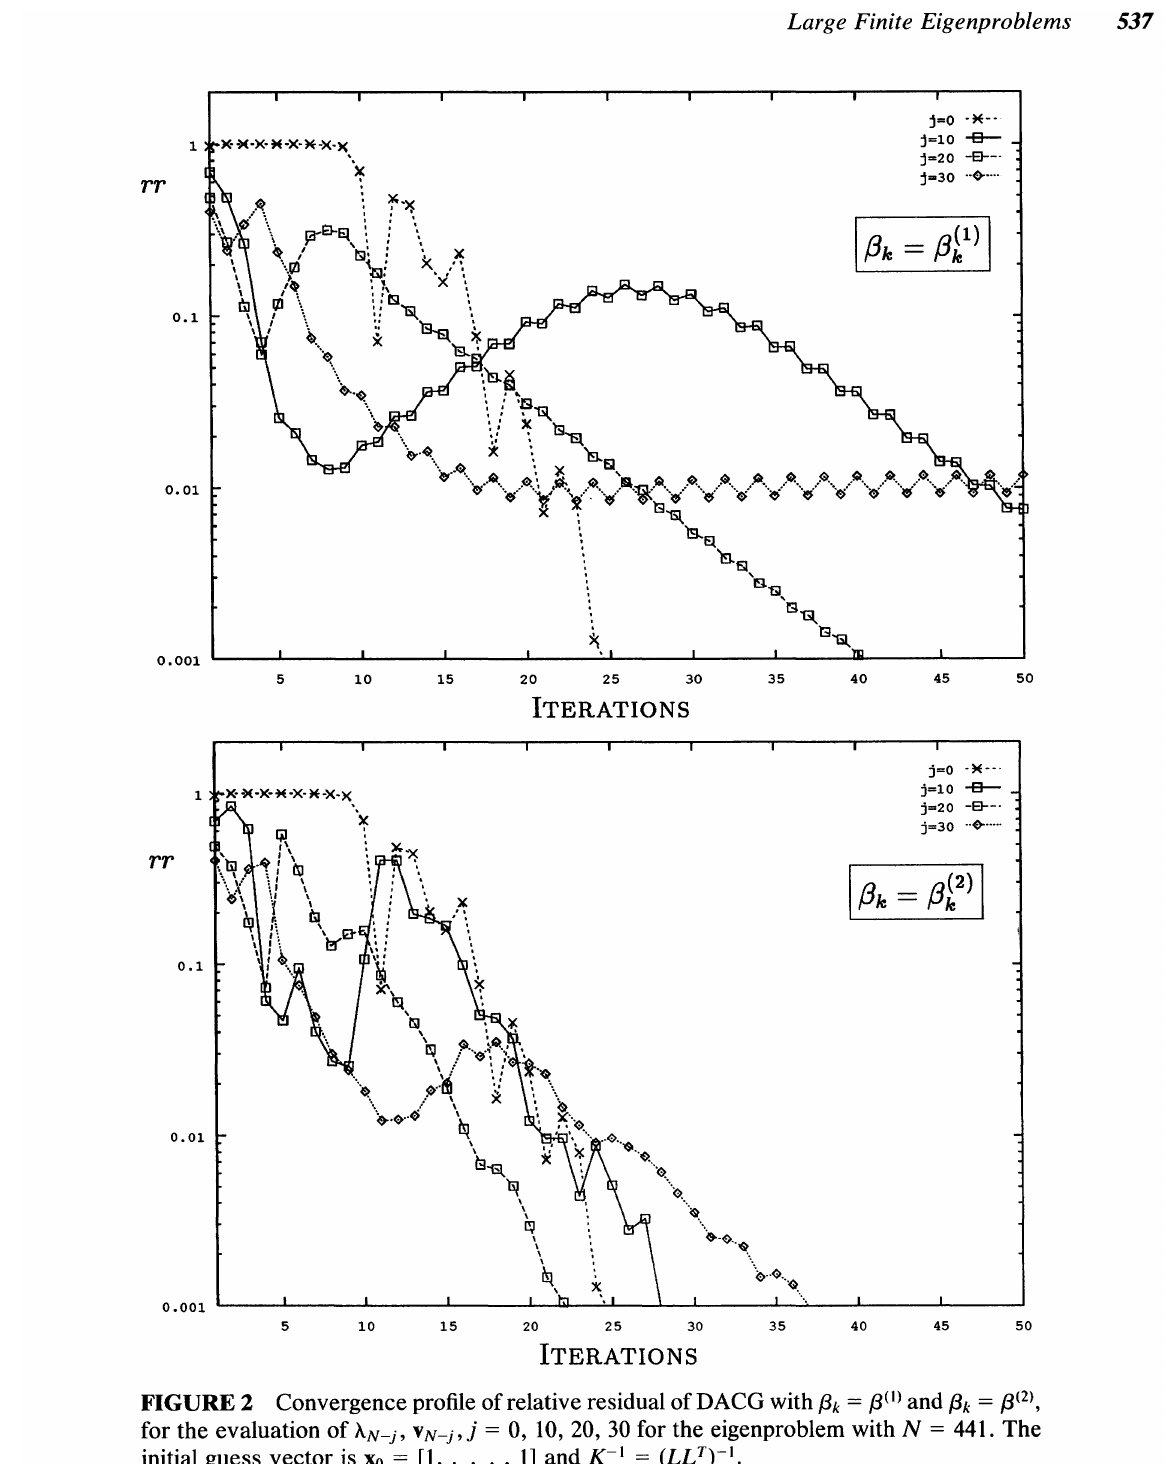
FIGURE 2 Convergence profile of relative residual of DACG with 13k = 13(1) and 13k = 13(2), for the evaluation of AN-j, VN-j,j = 0, 10,20,30 for the eigenproblem with N = 441. The initial guess vector is Xo = [1, ... , 1] and K-I =